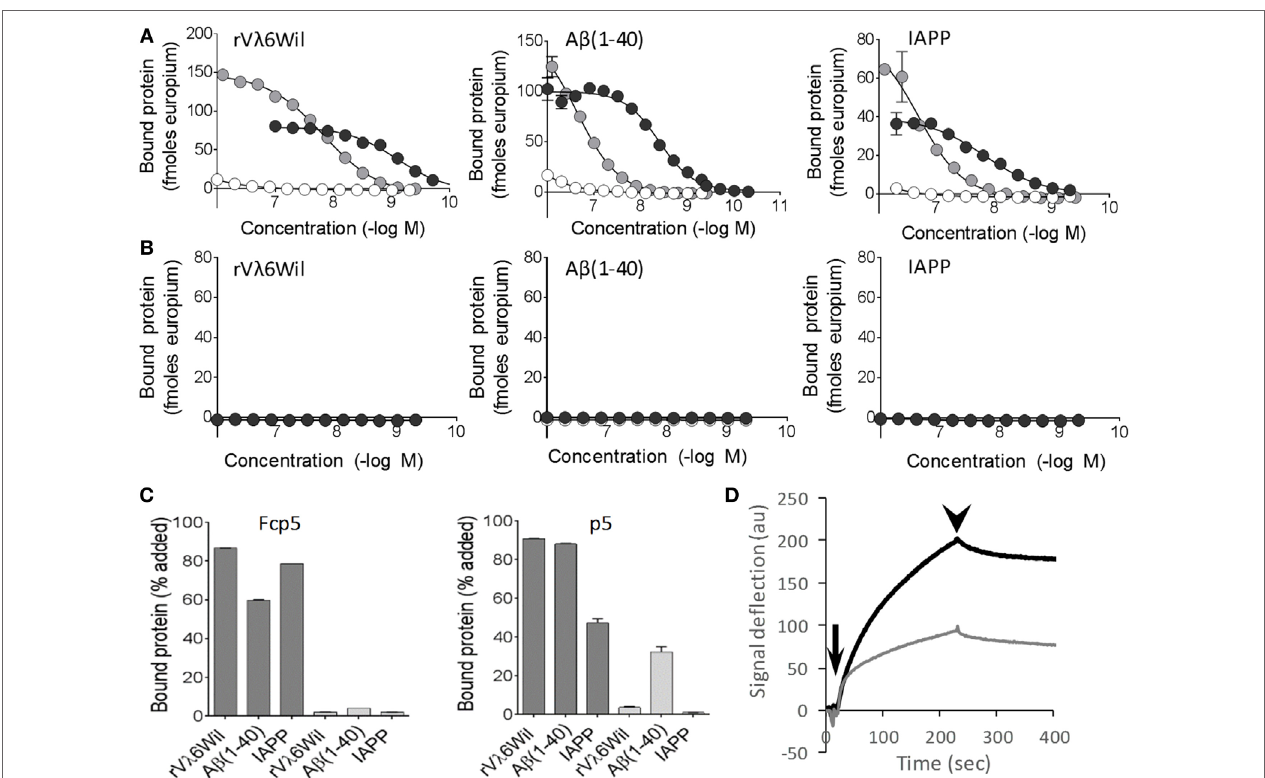
FigUre 2 | Fcp5 binds the three major forms of amyloid-like fibrils. (a) The Fcp5 construct (black) and peptide p5 (gray), but not Fc2a (white), bound surface- adsorbed amyloid-like fibrils composed of rV λ 6Wil, A β (1–40), and IAPP. In each case, Fcp5 bound with greater affinity. (B) No reactivity of Fcp5 (black) or p5 (gray) was observed when non-fibrillar rV λ 6Wil, A β (1–40), or human IAPP(Ile26Pro) were adsorbed to the surface of microplate wells. (c) Pulldown assays were performed using 125 I-Fcp5 and peptide 125 I-p5 in PBS (dark gray) and 1 M NaCl (light gray) to assess the importance of electrostatic interactions. (D) Kinetic binding of Fcp5 (black) and p5 (gray) to rV λ 6Wil fibrils by surface plasmon resonance. Injection (arrow) and washout (arrowhead) phases occurred over 200